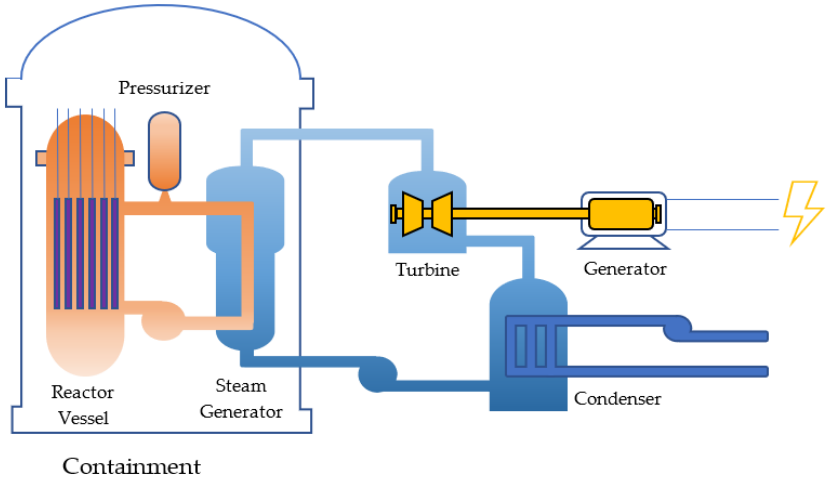
Figure 6. Major components of a nuclear power